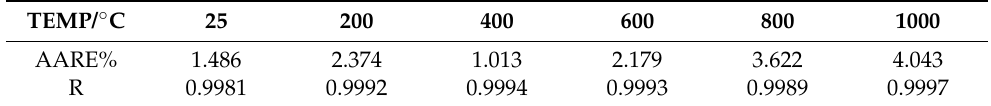
Table 2. Comparison of high temperature tensile finite element simulation and experimental results of 316L material.